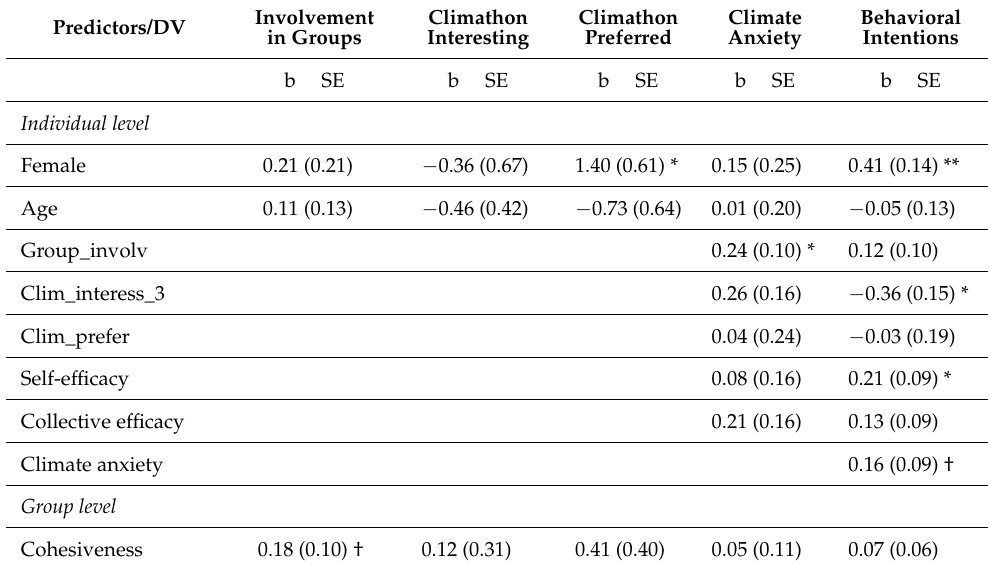
Table A3. Results of multilevel regressions, with the score of perceived cohesiveness as group- level